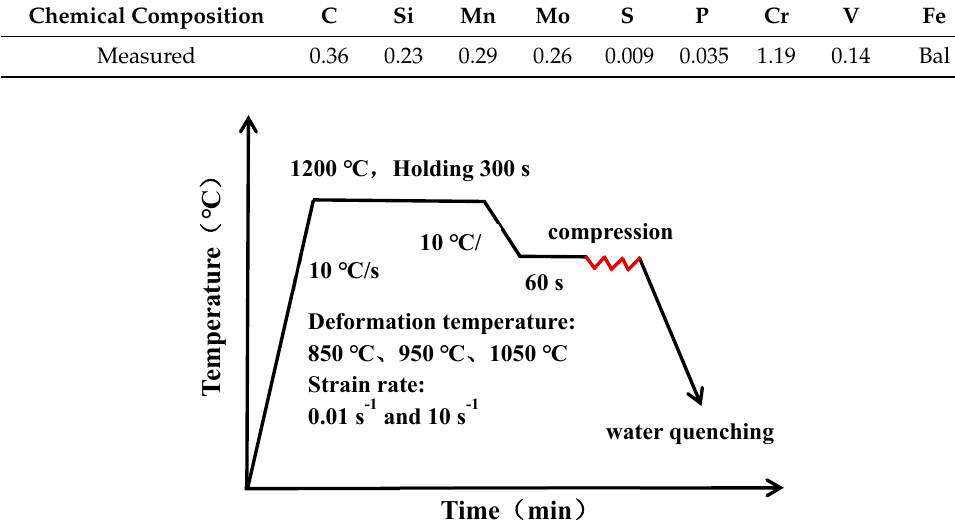
Figure 1. Schematic representation of hot compression test.